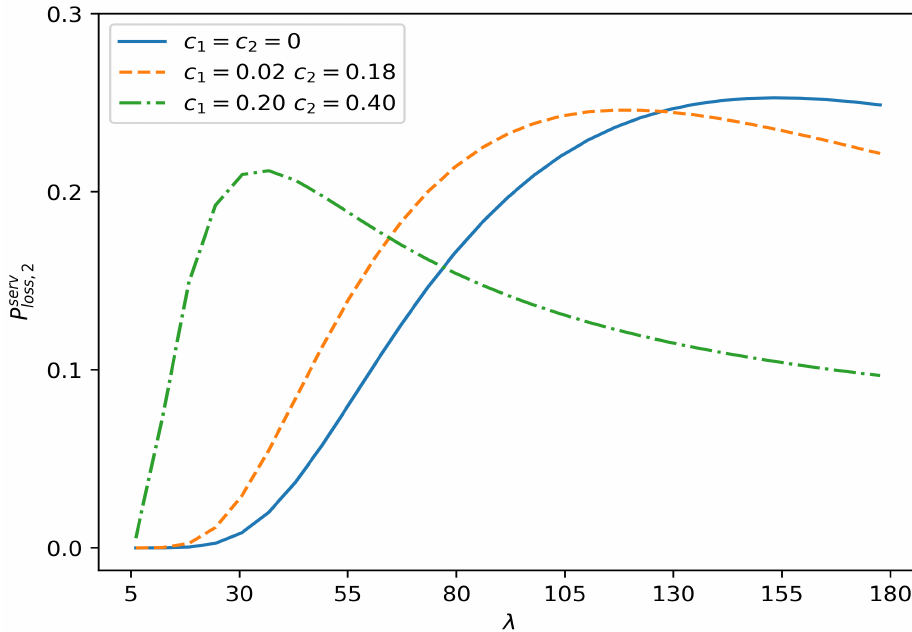
Figure 3. The dependence of the probability P serv coefficients of